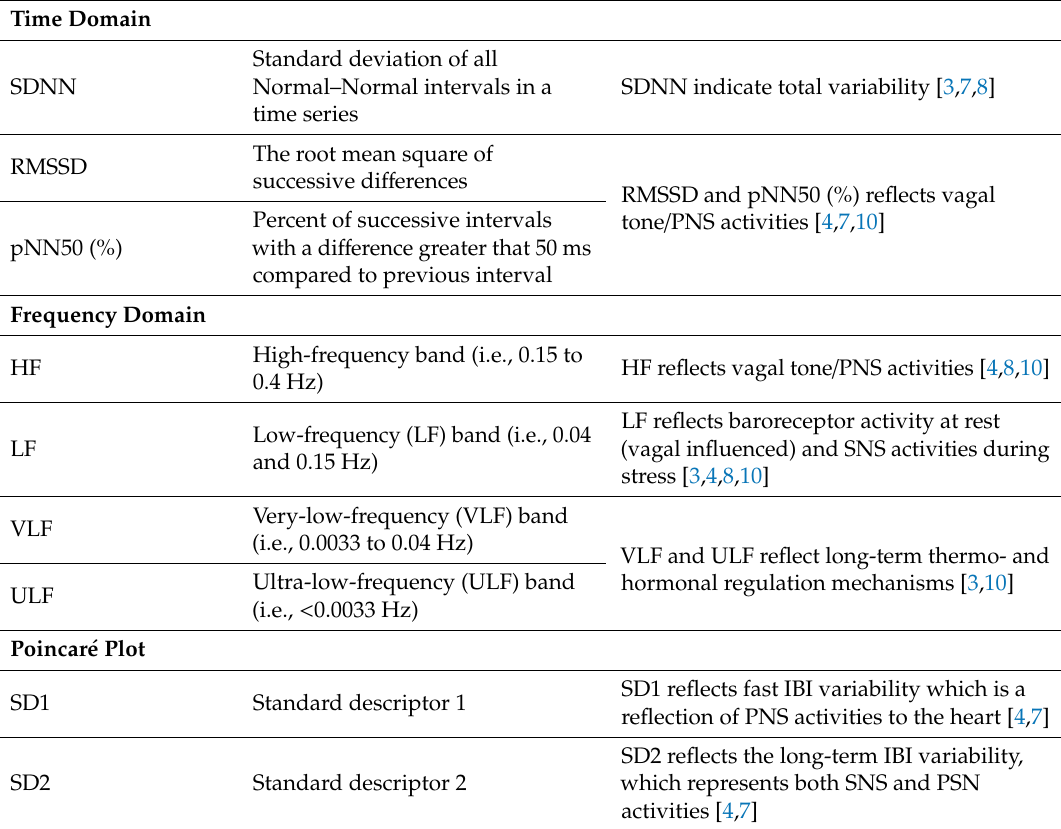
Table 1. The three heart rate variability (HRV)